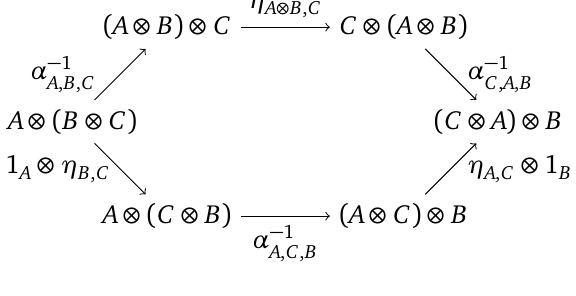
Figure 4: The second hexagon